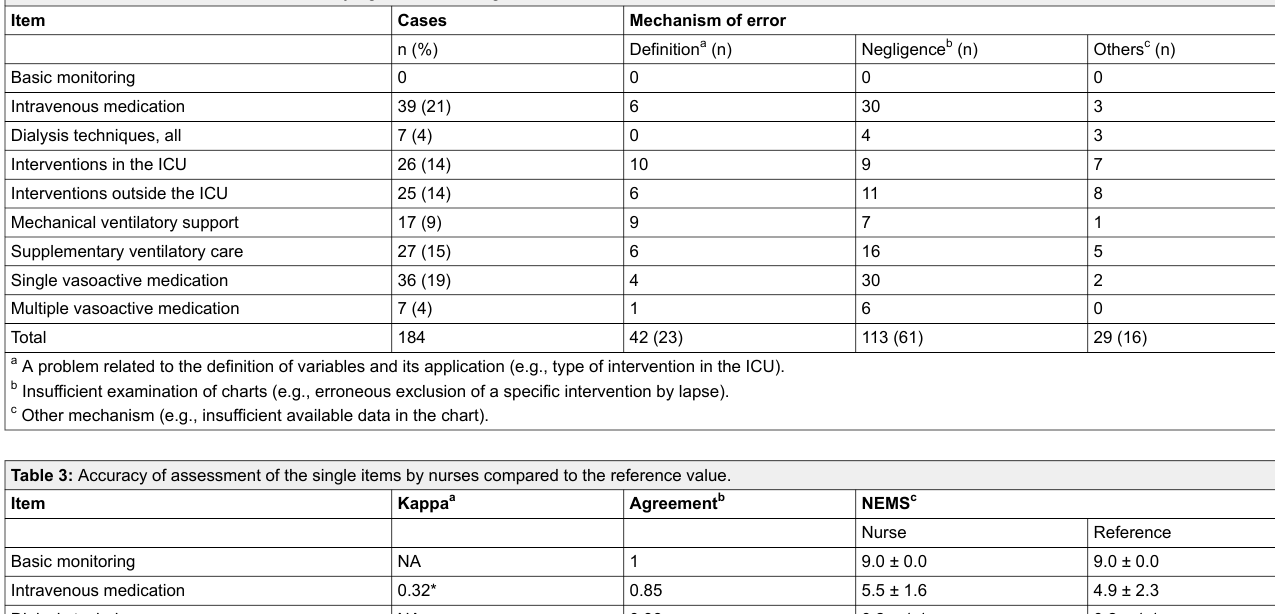
Table 2: Differences between the reviewers’ judgments according to the mechanism of error.